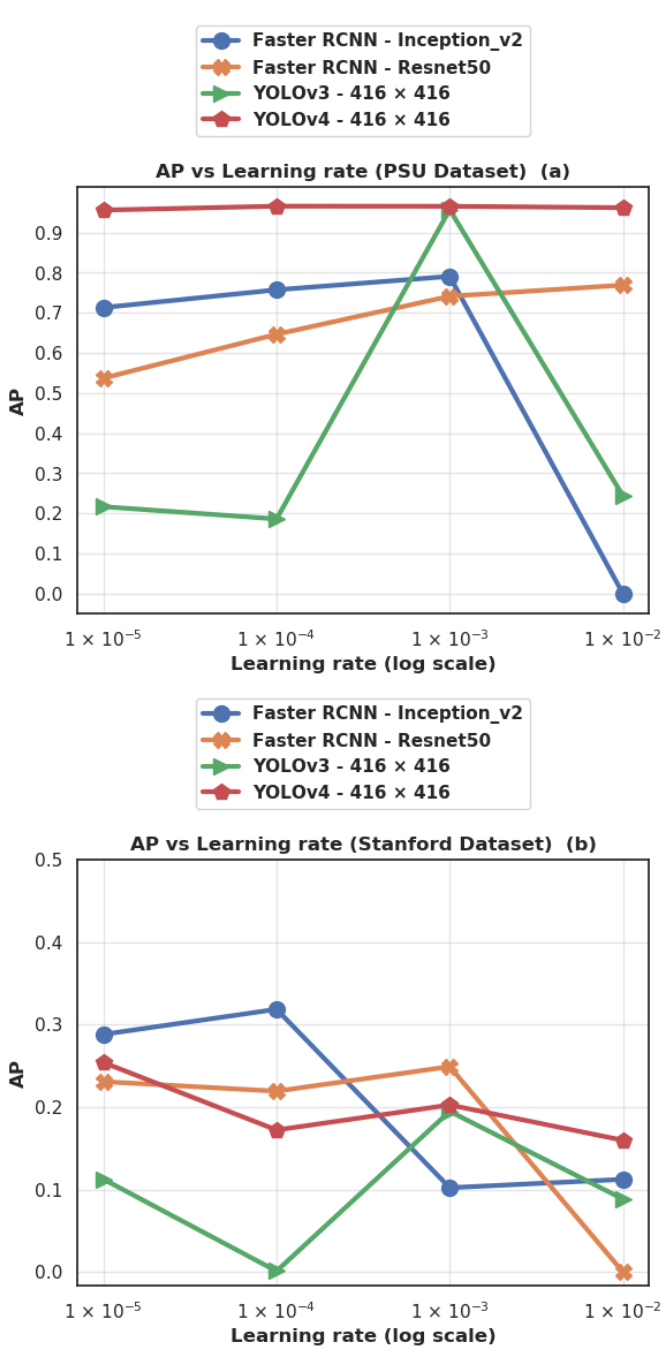
Figure 21. Dependency between the AP (Average Precision) and the learning rate, on the PSU (Prince Sultan University) ( a ) and Stanford ( b )